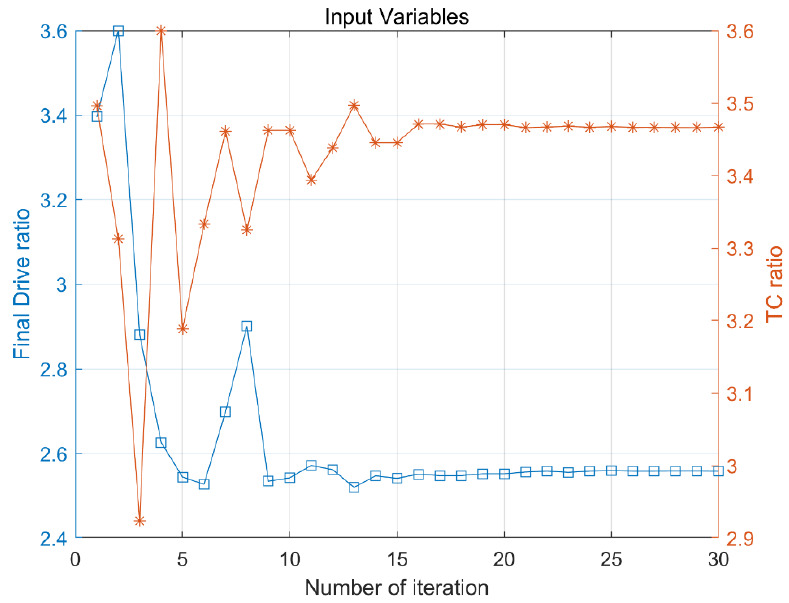
Figure 12. Optimization results for the FD(blue, cube) and TC(orange, asterisk) ratios. Table 6. Acceleration performance for Case 3.